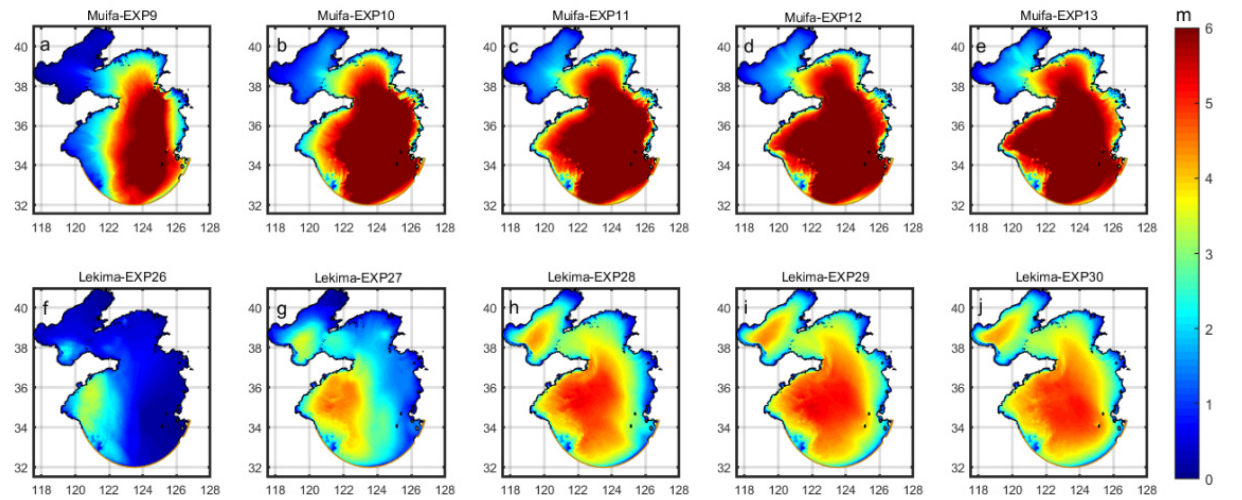
Figure 11. Spatial distribution of the significant wave height when the RMW was ( a ) 10 km, ( b ) 20 km, ( c ) 30 km, ( d ) 40 km, and ( e ) 50 km based on Typhoon Muifa and ( f ) 10 km, ( g ) 20 km, ( h ) 30 km, ( i ) 40 km, and ( j ) 50 km based on Typhoon Lekima.